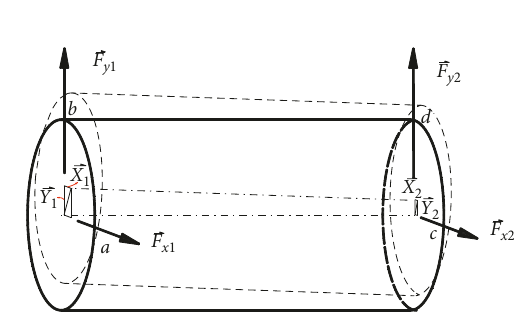
Figure 5: Sizes of seal.